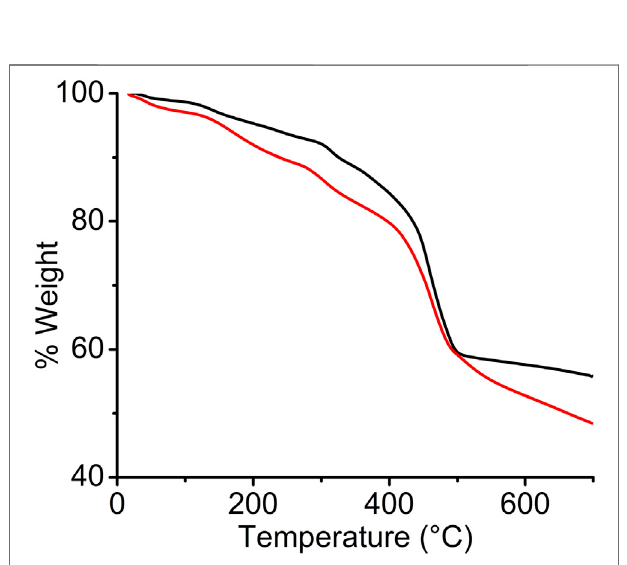
FIGURE 3 | TGA pro fi les of pristine (black) and I 2 -treated (red) wavy -MOF.